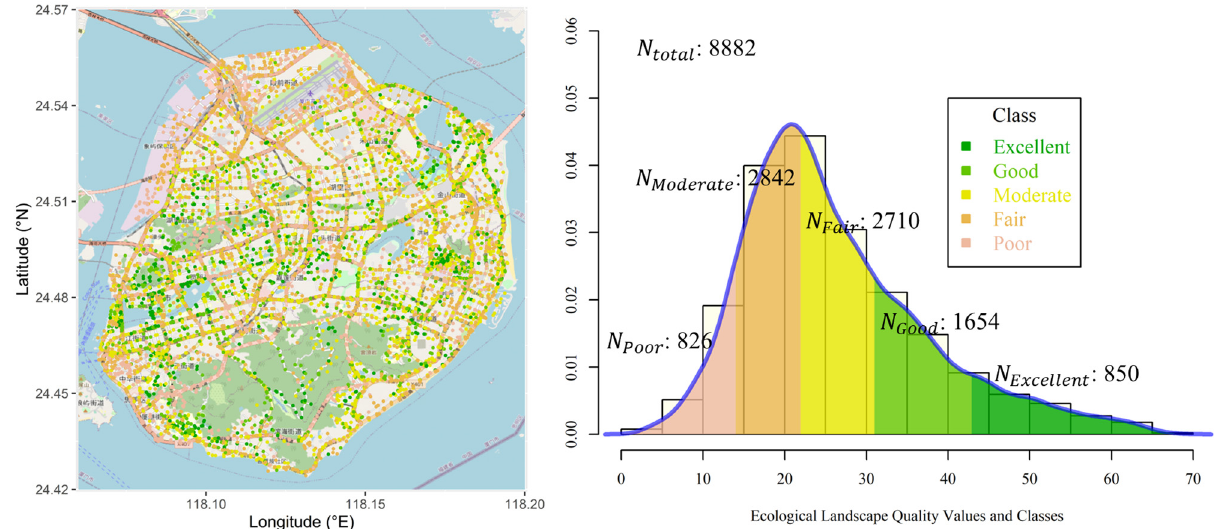
Figure 11. The spatial ( left ) and density ( right ) distribution for ecological landscape quality values and classes.